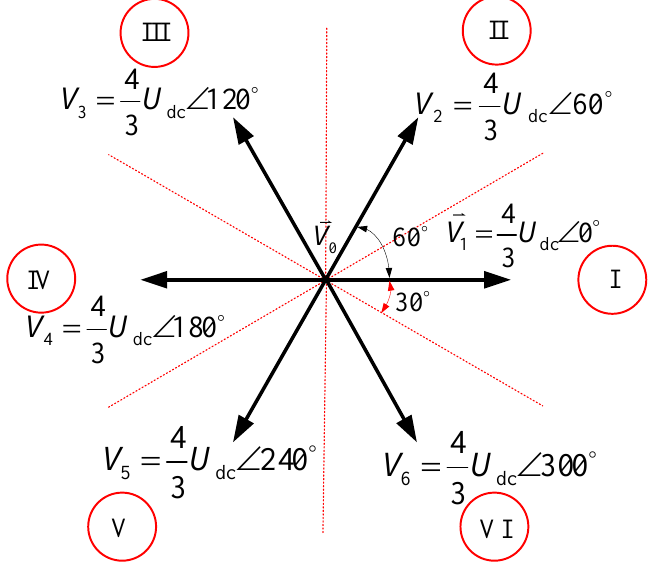
Figure 6. Voltage Figure 6. Voltage vectors.